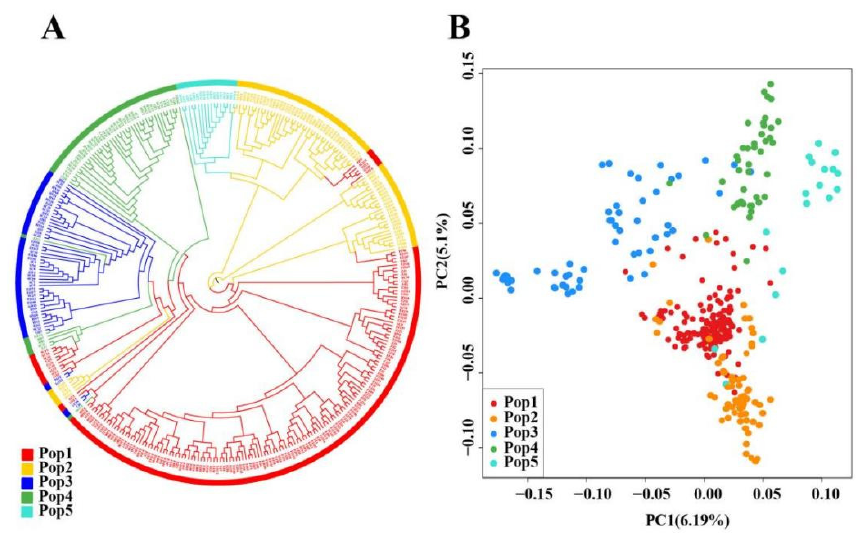
Figure 2. Unrooted neighbor-joining tree and PCA analysis based on core SNPs data set. ( A ) Unrooted neighbor-joining tree; ( B ) PCA analysis.